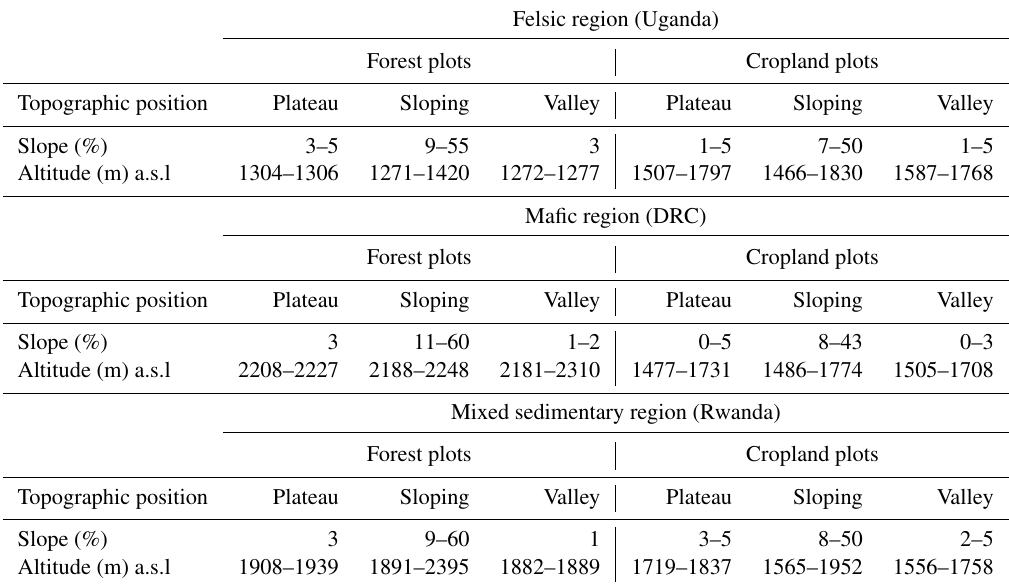
Table 1. Topographic information of TropSOC plots across different geochemical regions and land use. Slope and altitude are displayed as minimum and maximum values. Each topographic position per geochemical region contains the range between three and seven field replicate